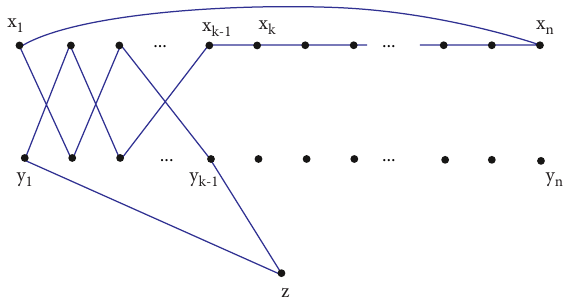
( G ) from a cycle C n + 1 in μ